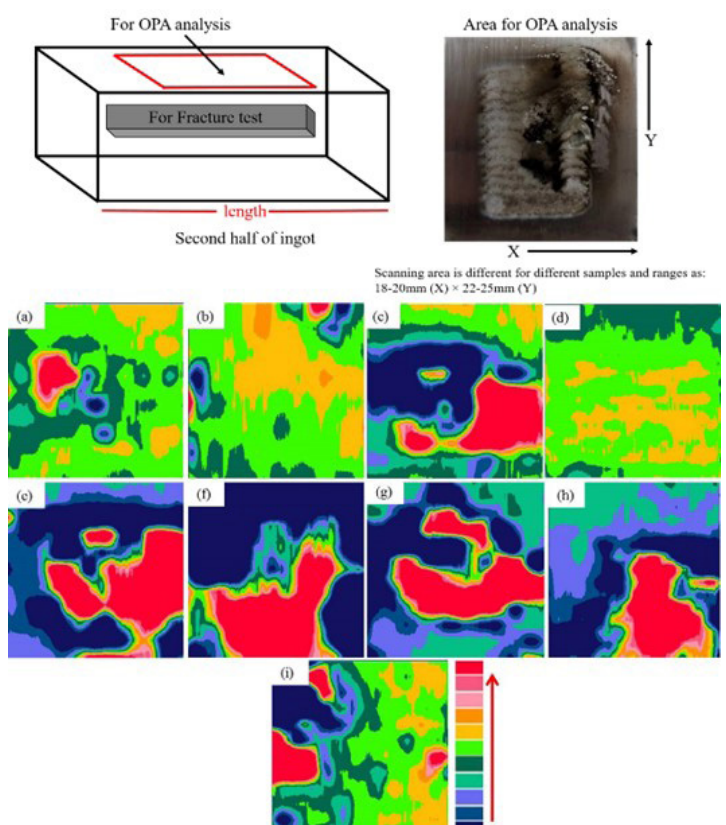
Figure 7. Two-dimensional contour map of carbon macrosegregation in the longitudinal section of ingot, (a-d) 120s with SR of 1mm, 2mm, 3mm and 4mm, respectively; (e-h) 180s with SR of 1mm, 2mm, 3mm and 4mm, respectively and (i) Without